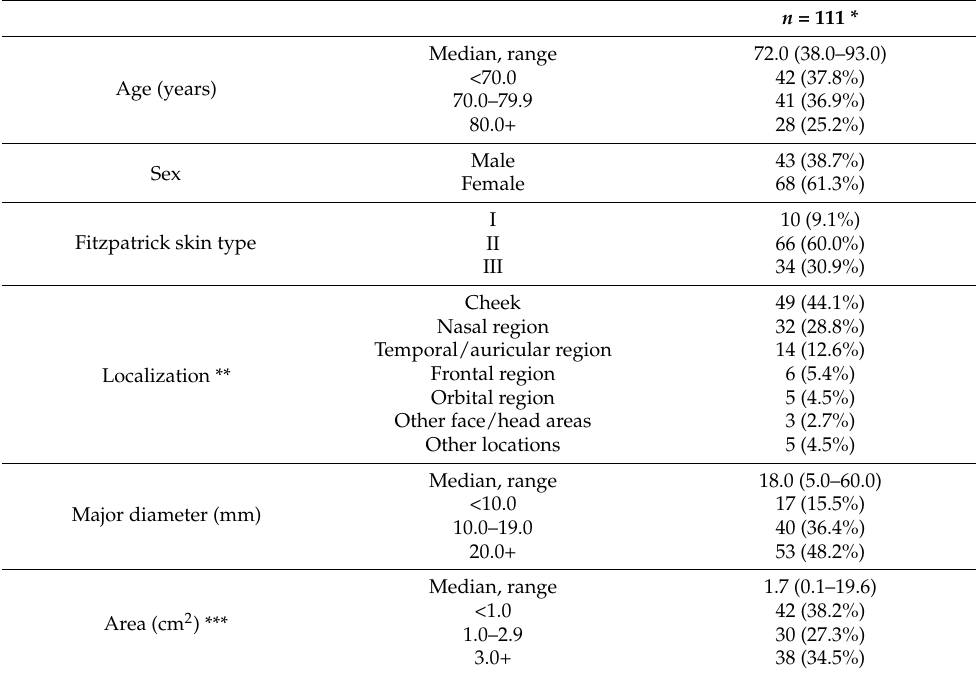
Table 1. Demographics and clinical characteristics of the study population.